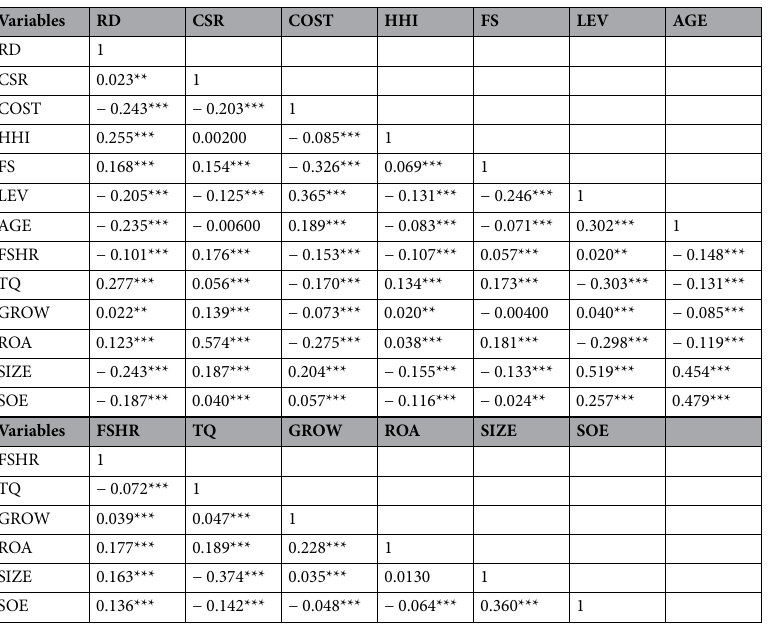
Table 3. Correlation analysis of variables. ***, ** and * respectively indicate that the parameter estimation is significant at the levels of 0.01, 0.05 and